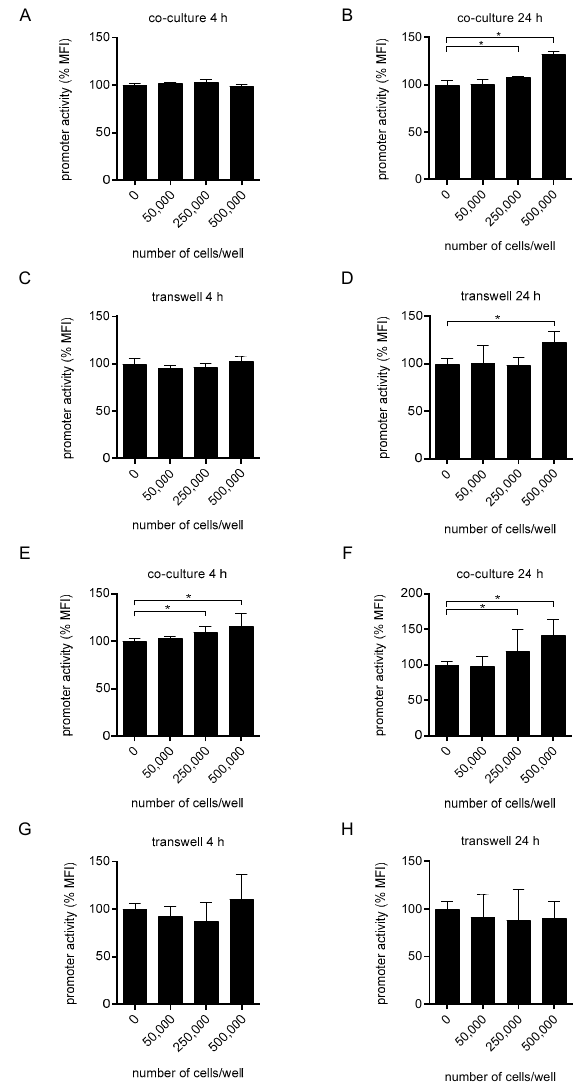
Figure 2. Differentiation of the monocytic cell line THP-1 to macrophages increases their efficacy to induce the P2 promoter. We cultured CFT073 pPc2398:gfpmut:KAN in RPMI-1640 medium in the absence or presence of titrated amounts of LPS-stimulated (100 ng/mL) monocytic THP-1 cells as indicated. Bacteria and THP-1 cells were either co-cultured (1.6 × 10 7 bacteria/well, ( A , B )) or cultured in transwells (1.6 × 10 8 bacteria/well, ( C , D )). We determined the P2 promoter activity after a culture period of 4 ( A , C ) or 24 h ( B , D ) by flow cytometry. In ( E – H ) we repeated the experiments described in ( A – D ) with the exception that we used THP-1 cells, which we differentiated with PMA (100 ng/mL) for three days. Cells were not stimulated with LPS. Graphs depict three ( A – D , G , H ) or six ( E , F ) independent experiments, each experiment was performed with three replicates. The measured promoter activity in ( A – H ) was normalized to the “0” control. * p < 0.05, ANOVA post-hoc